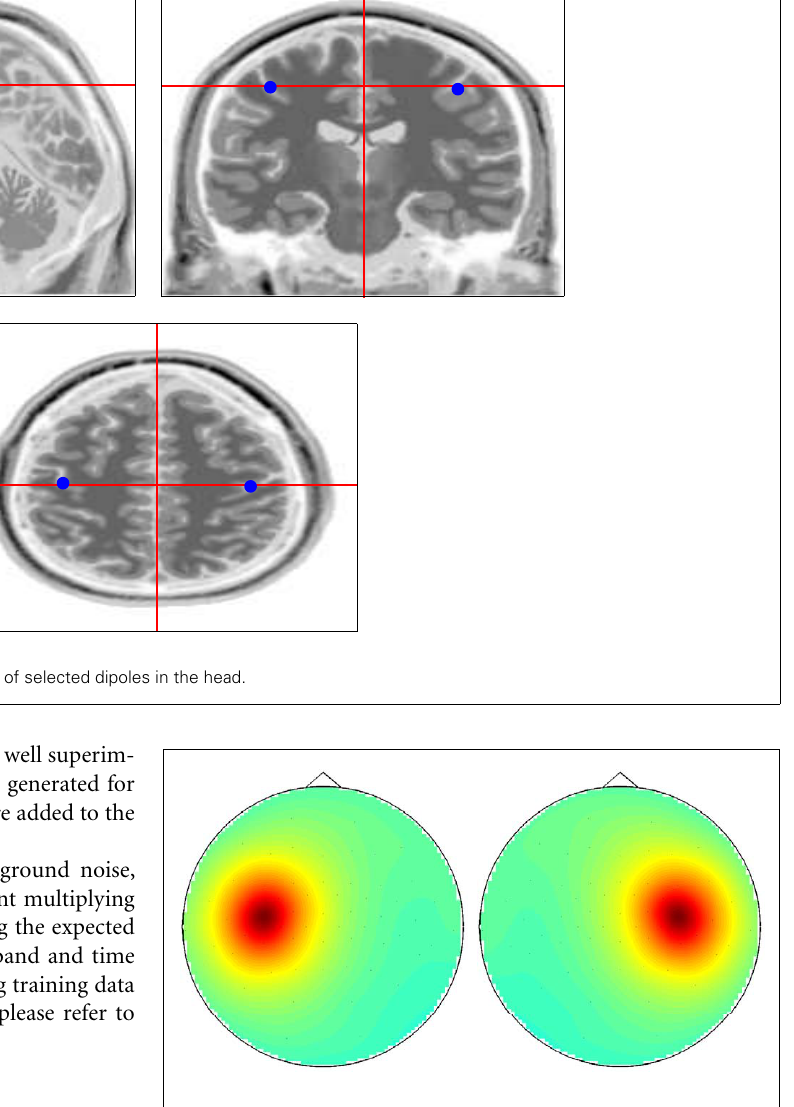
FIGURE 11 | (Data Set 1 – artificial). Power topographies at the µ rhythm frequency generated by the